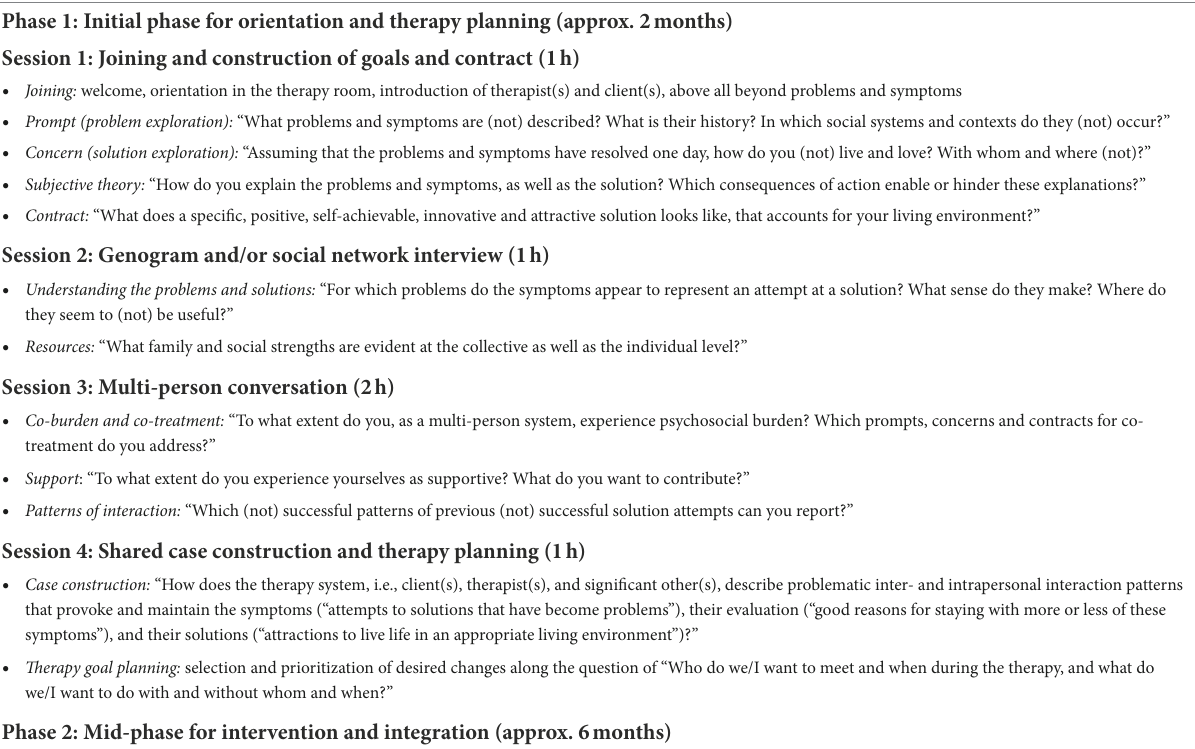
TABLE 3 Course of ISFT in social anxiety disorders, ideal type (Schweitzer et al., 2020) The number of multi-person conversations is perceived as the minimum of sessions where significant social system members are involved. It is welcomed to increase multi-person conversations up to a complete multi-person